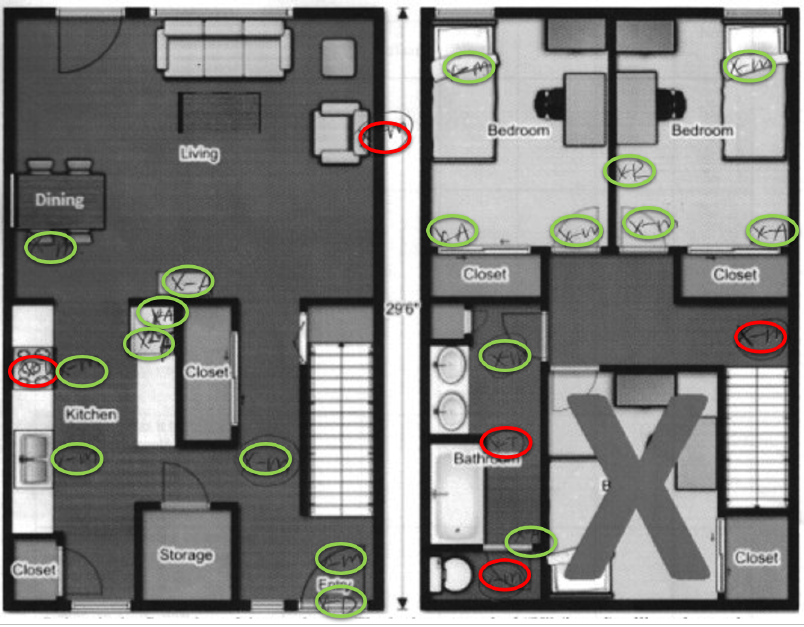
Figure 9. An example of evaluating an